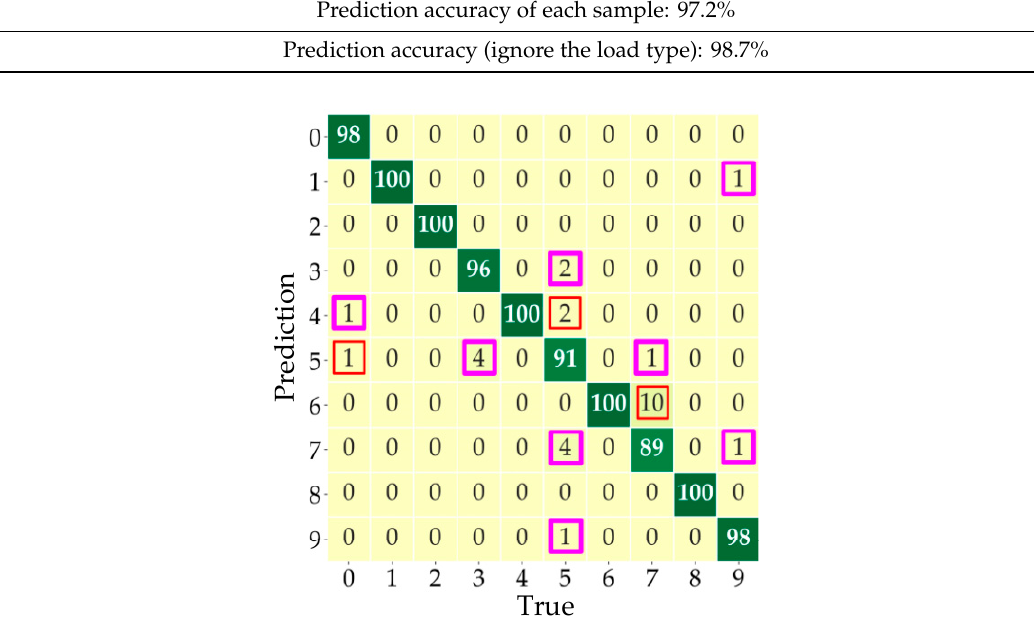
Figure 11. The confusion matrix for multi-loads.